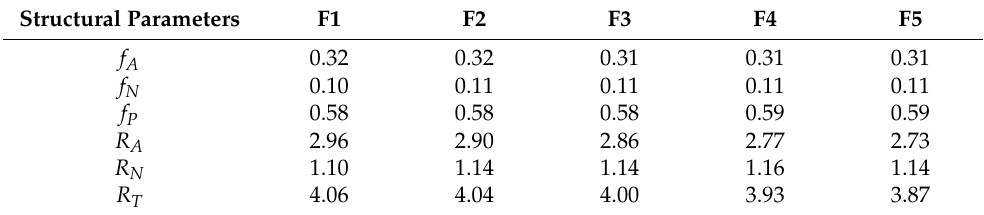
Table 4. The average molecular structural parameters of FCC slurry oil before and after